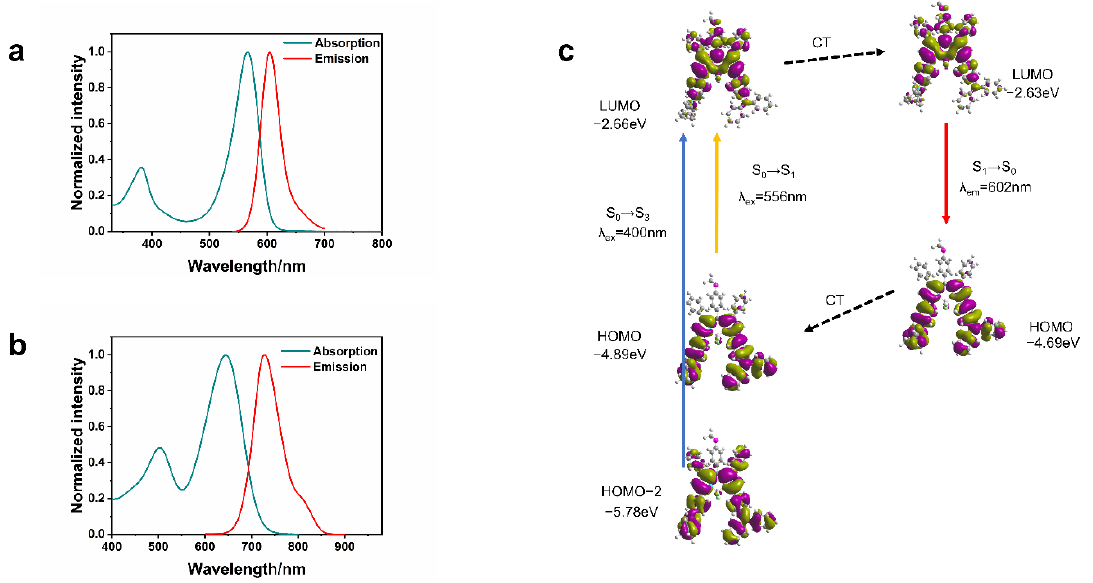
Figure 1. ( a ) The absorption (cyan line) and fluorescence (red line) spectra of BDP-A. ( b ) The absorption (cyan line) and fluorescence (red line) spectra of BDP-B. ( c ) Rationalization of the large Stokes shift of BDP-B: the geometry relaxation upon photoexcitation and the frontier molecular orbitals (MOs) involved in the vertical excitation (i.e., UV–Vis absorption, the left columns) and emission (right column) of BDP-B. Excitation and radiative processes are marked as solid lines and the nonradiative processes are marked by dotted lines.